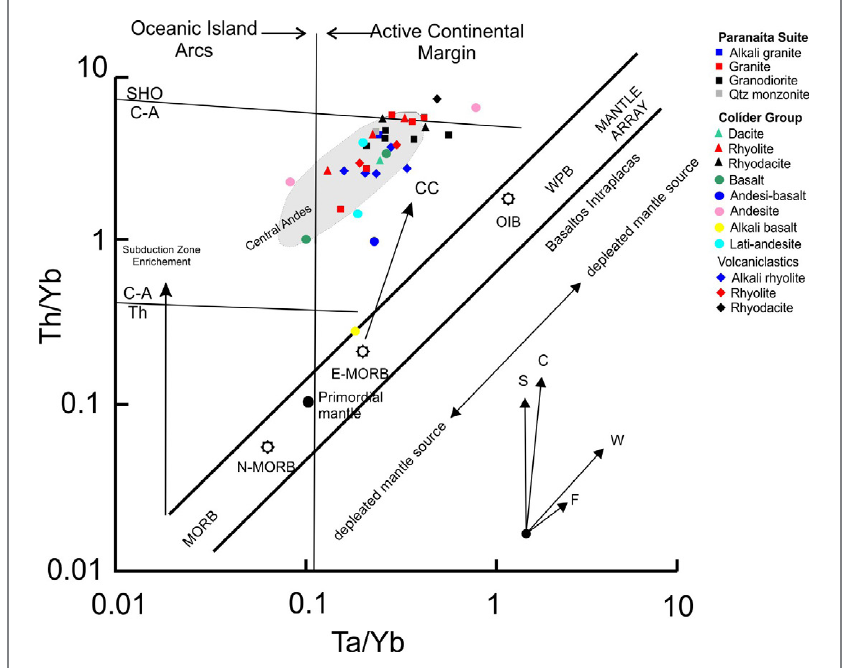
FIGURE 7 - Th/Yb versus Ta/Yb tectonic-magmatic discrimination diagram (Pearce et al. 1984) for the samples of the Volcanic Domain. Uncontaminated intracontinental plate basalts should plot in the WPB region. Vectors indicate subduction-related components (S), within-plate enrichment (W), crustal contamination (C) and fractional crystallization (F). CC - crustal contamination. Th - Tholeiitic field, C-A calc-alkaline